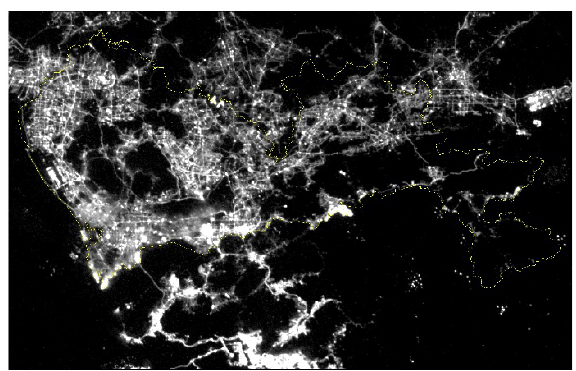
Figure 1. LJ1-01 night-time light remote sensing original image (Sept.3, 2018)